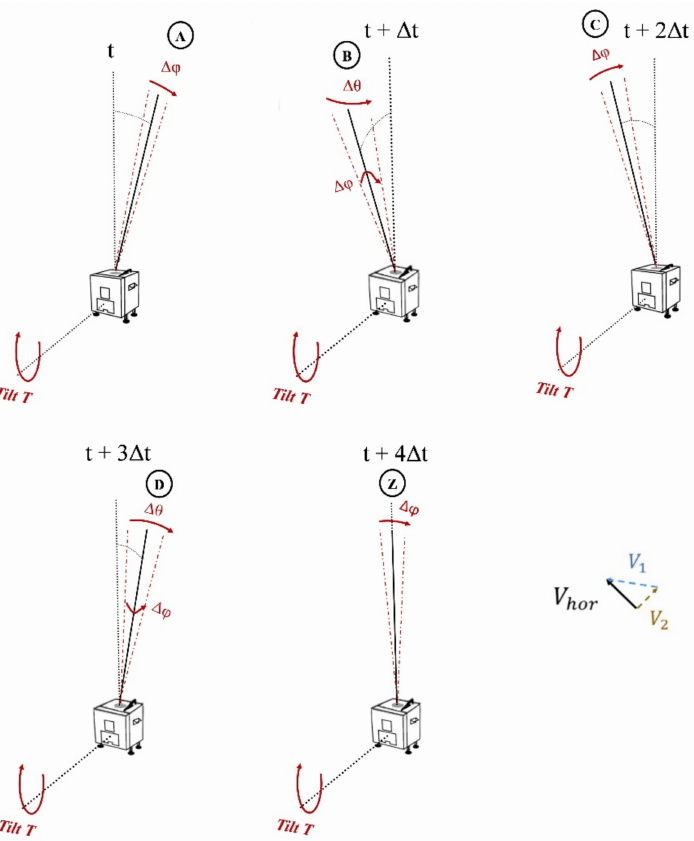
Figure 4. Diagram representation showing the influence of a tilt change T (roll or pitch) on the angles ϕ and θ of the five measurement directions of the WindCube v2 ® denoted A, B, C, D, Z (side view). The suggested times are added to recall the temporality of the WindCube measurement. The horizontal velocity is decomposed into two components: V 1 and V 2